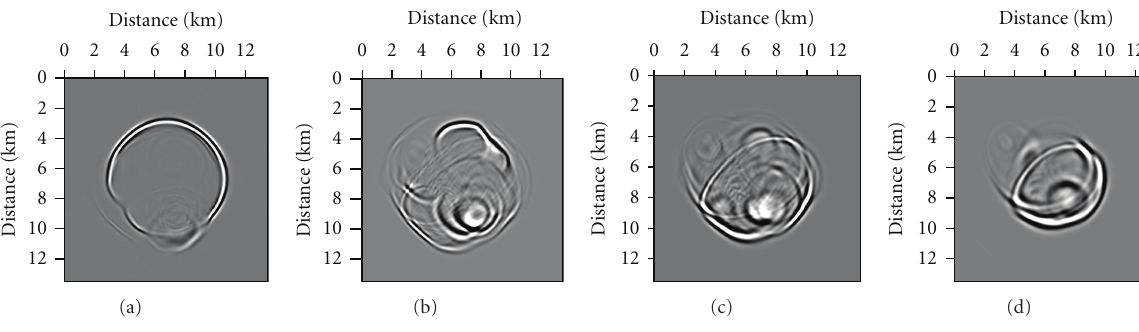
Figure 6: Impulse response of FFD migration with two-way splitting. Horizontal cuts as in Figure 4.